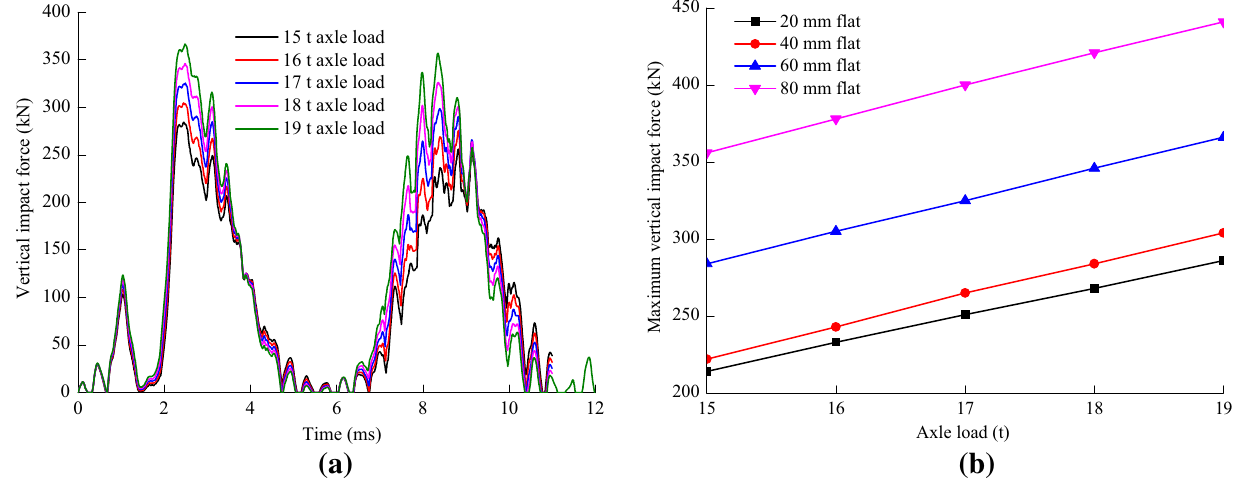
Fig. 12 Influence of axle load on the vertical wheel–rail impact response. a Typical vertical impact force versus time curves. b Maximum vertical impact force